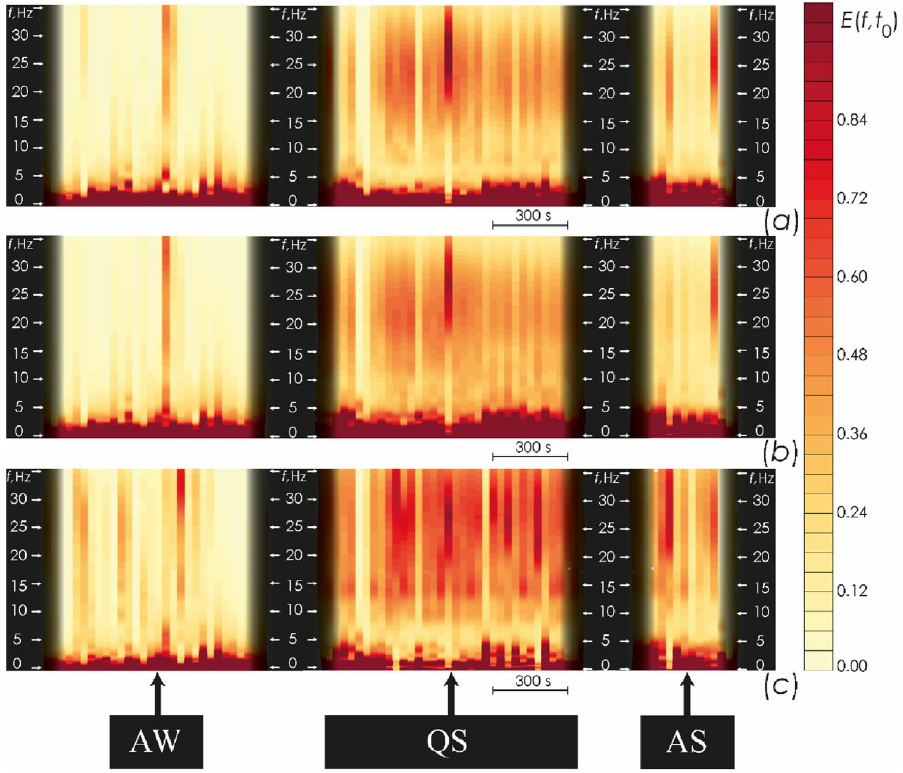
, averaged in the time window Δ t f , t 0 (cid:30) (cid:31)